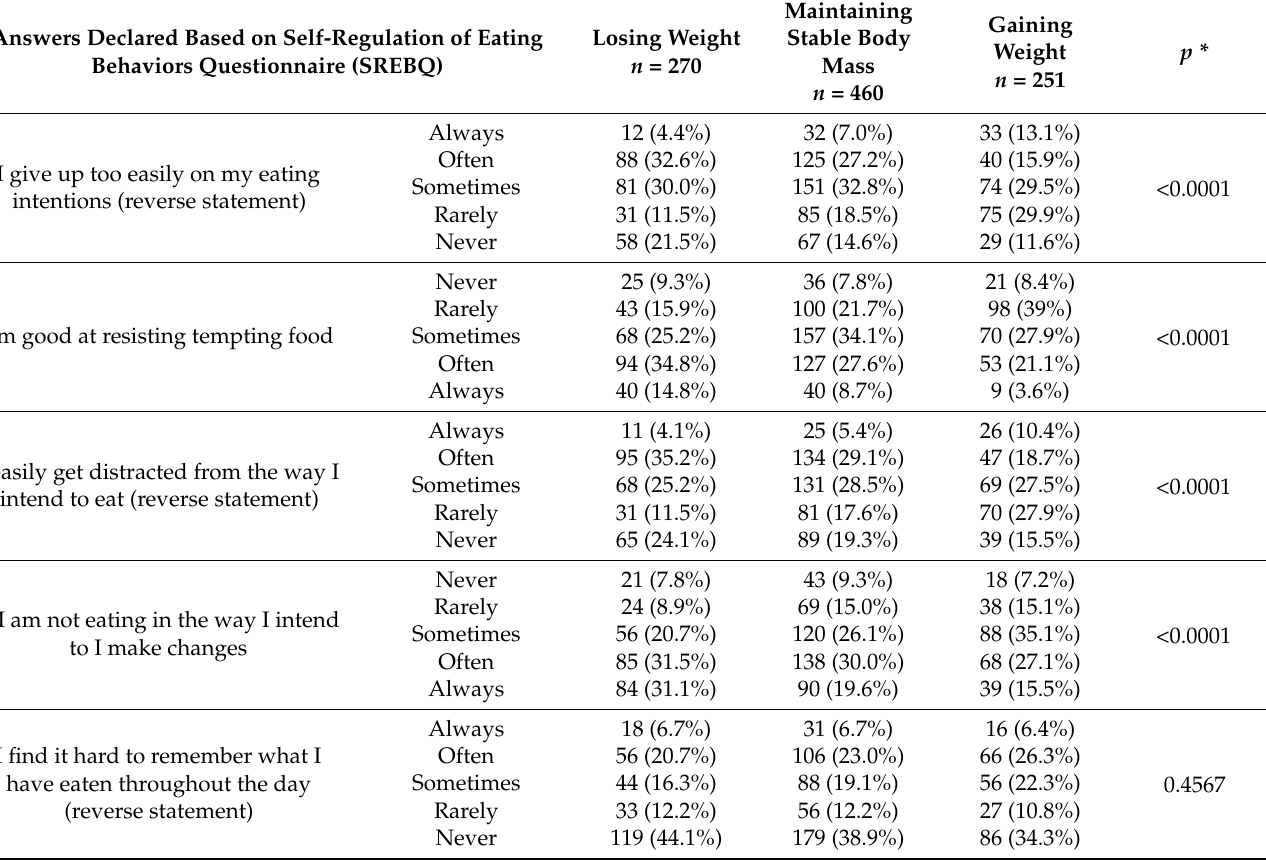
Table 5. The self-regulation of eating behaviors assessed using the Self-Regulation of Eating Behaviour Questionnaire (SREBQ), within the Polish Adolescents’ COVID-19 Experience (PLACE-19)